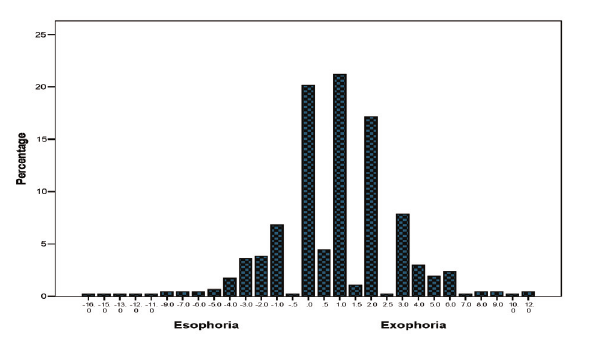
Figure 1 Distribution of horizontal heterophoria for distance vision for the total sample. A large proportion of the sample is exophoric and the peak is at 1 pd exophoria.